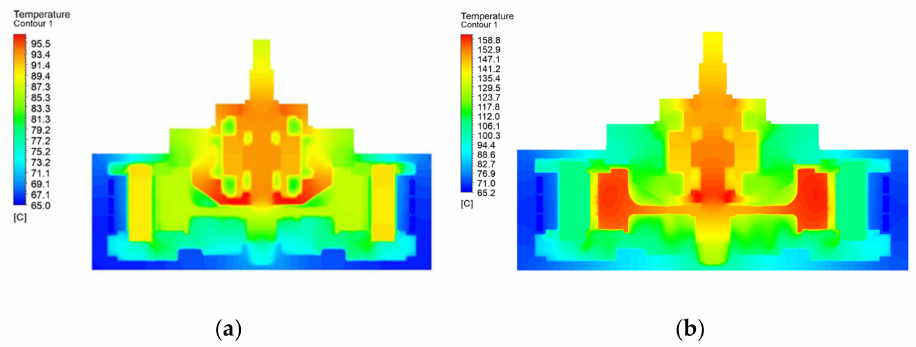
Figure 6. Temperature contour of in-wheel motor with simple water channel: ( a ) Base speed; ( b ) maximum